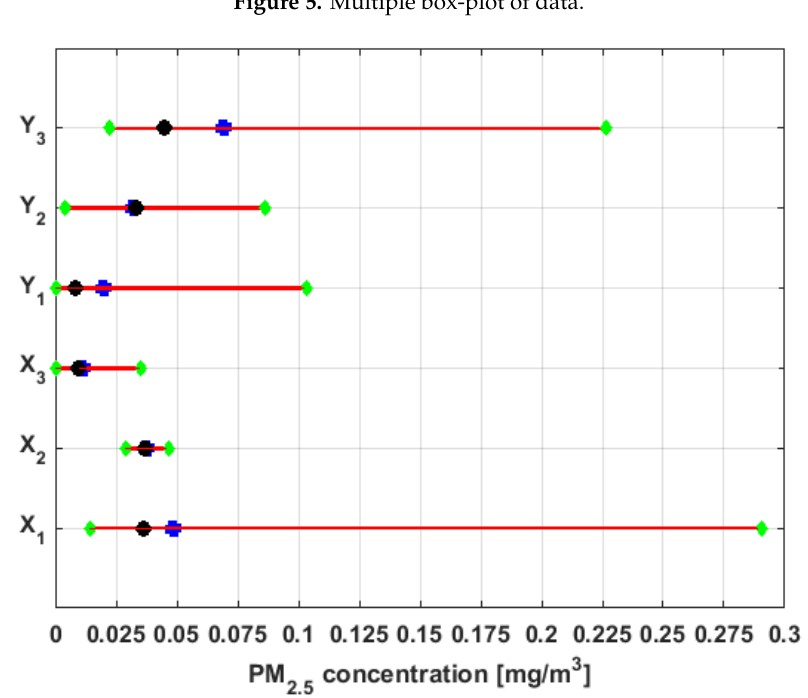
Figure 6. Empirical confidence intervals for the median with a confidence level of 95%. Median: Black circle; Mean: Blue square; Ends of the intervals: Green diamond.